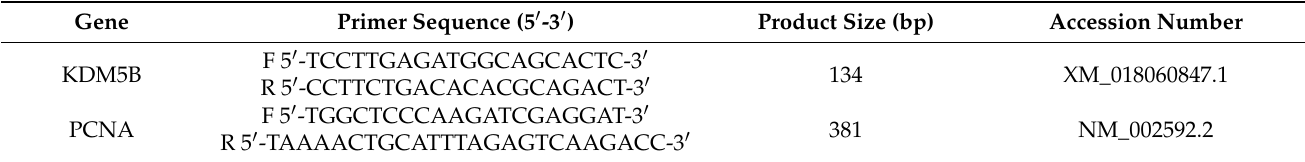
Table 2. Primer sequences, predicted product size of genes, and accession number for RT-qPCR.